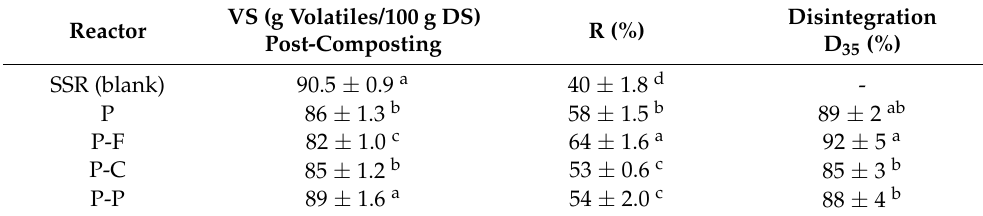
Table 2. Volatile solids (VS) after the composting period of the disintegration test, the reduction in the volatile content (R) and disintegration percentage for the samples after 35 composting days of the SSR, control (P) and P films incorporating ferulic acid (P-F), p -coumaric acid (P-C) and protocatechuic acid (P-P). Mean values and standard